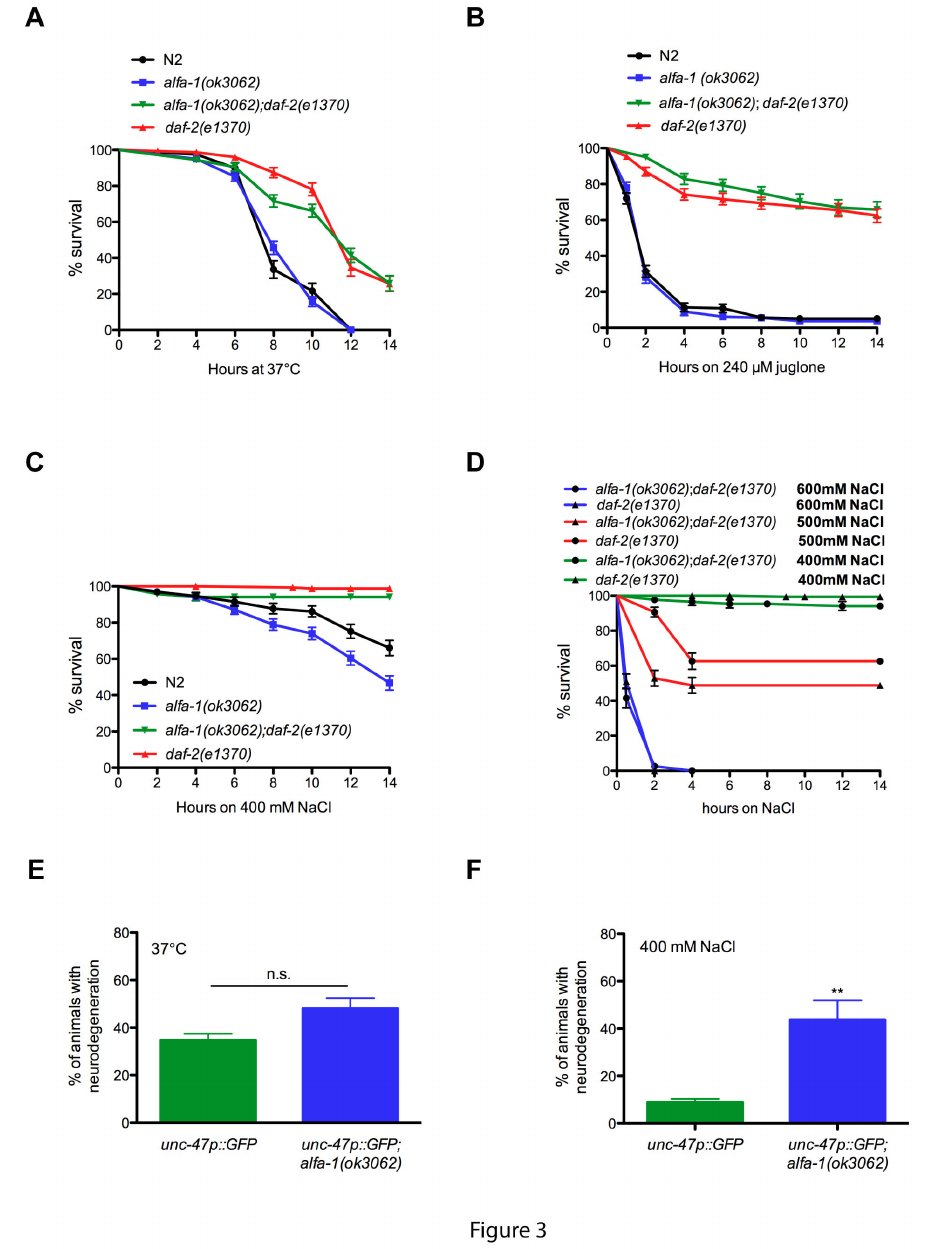
Figure 3. alfa-1(ok3062) mutants are sensitive to osmotic stress. (A) In thermal stress resistance assays, alfa-1(ok3062) mutants were indistinguishable from wild type N2 worms, and daf-2 (e1370) were not statistically different alfa-1(ok3062) ; daf-2 (e1370)